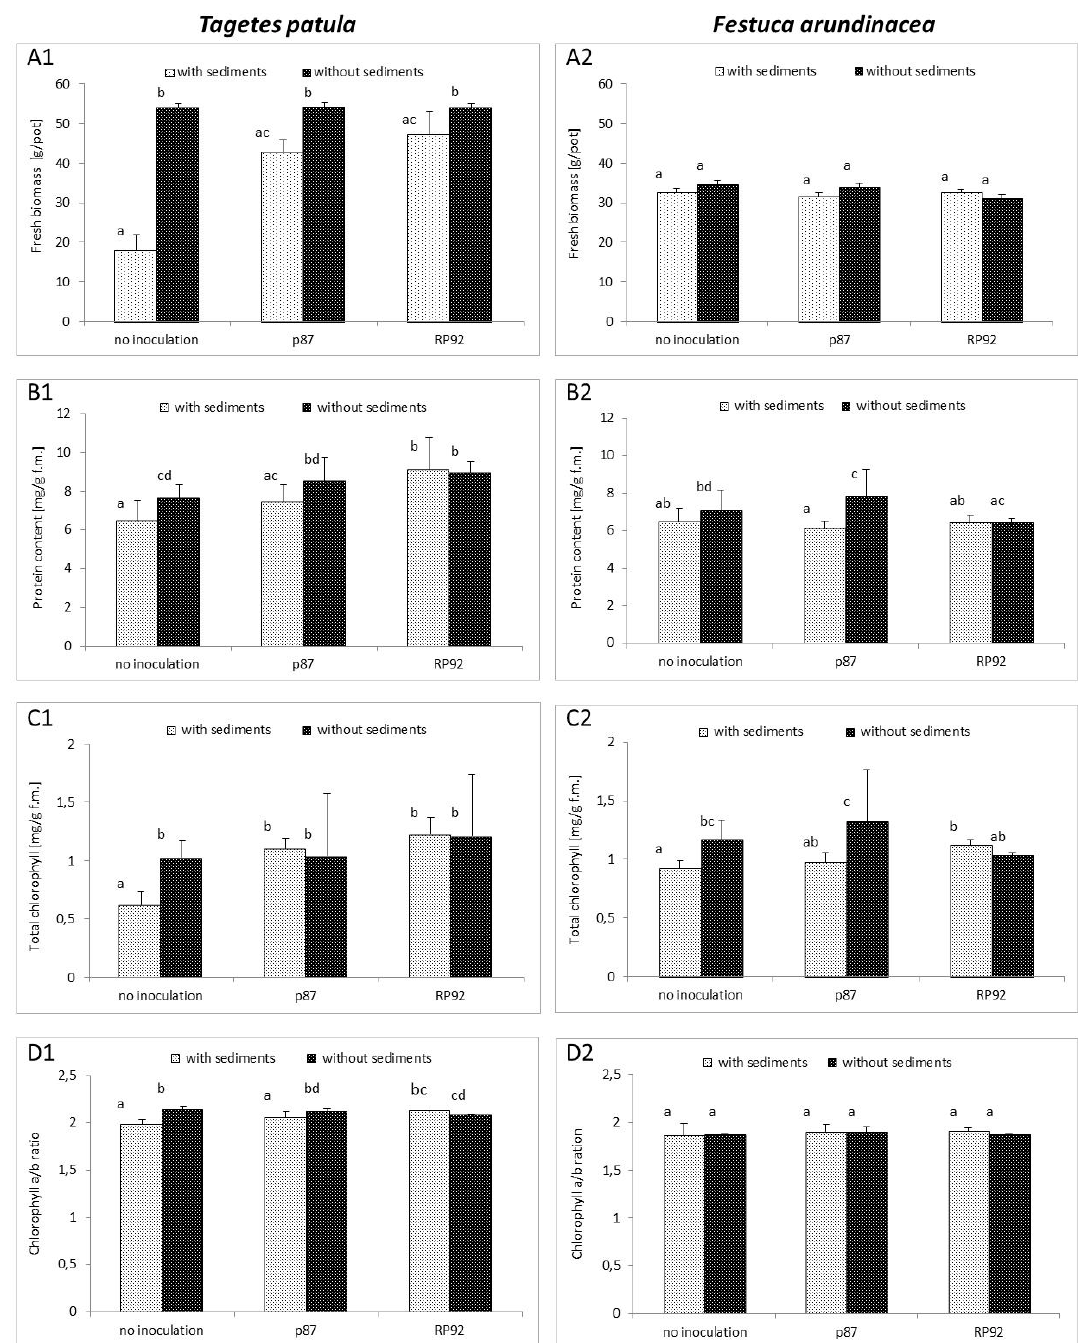
Figure 4. The effect of applied sediments and inoculation of growing medium (soil) with two bacterial strains p87 and RP92 on fresh biomass ( A 1, A 2), protein content ( B 1, B 2), chlorophyll content ( C 1, C 2) and chlorophyll a/b ratio ( D 1, D 2) in the leaf tissues of T. patula and F. arundinacea (at p < 0.05, the Duncan post-hoc test, the same letters indicate no statistically significant differences).